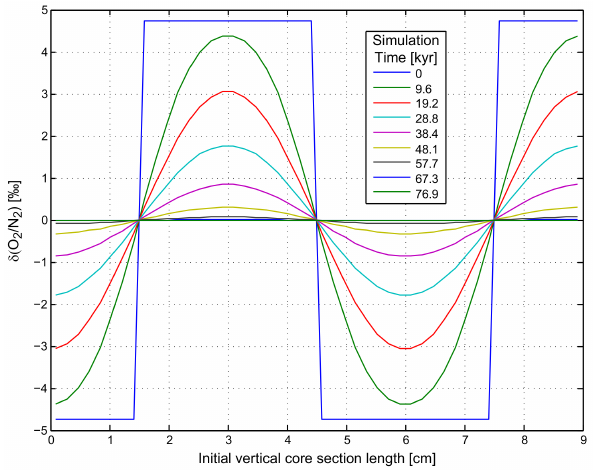
Fig. 4. Example of the model output of the O 2 /N 2 layering decline experiments using the SS parameters. The blue line shows the start- ing O 2 /N 2 distribution representing 3 layers (half a layer at each edge) with 3cm thickness and an amplitude of 4.8‰. The different coloured lines represent simulated distributions after a certain du- ration in the ice as indicated by the legend (in 1000yr [kyr]). From these results the corresponding decline in Fig. 5 is calculated (pur- ple line).